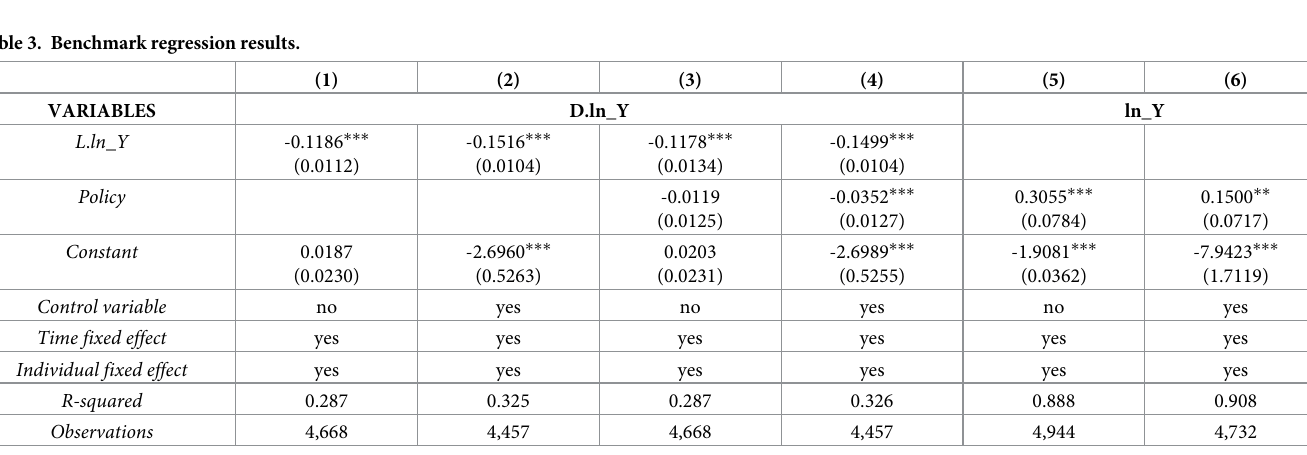
Table 3. Benchmark regression